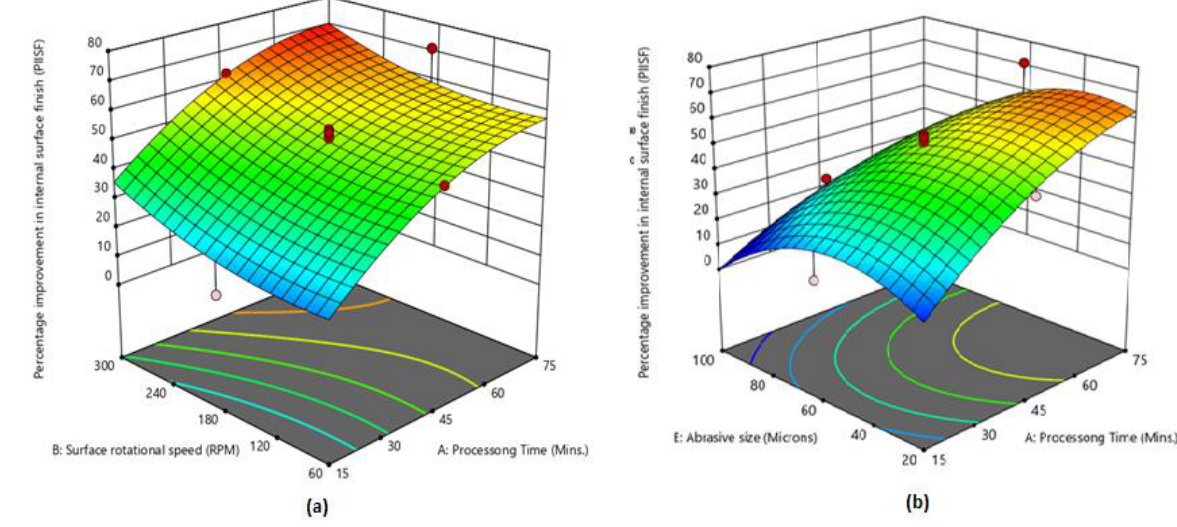
Figure 4. ( a ) Influence of processing time and rotational speed on PIISF; ( b ) influence of abrasive size and chemical concentration on PIISF.